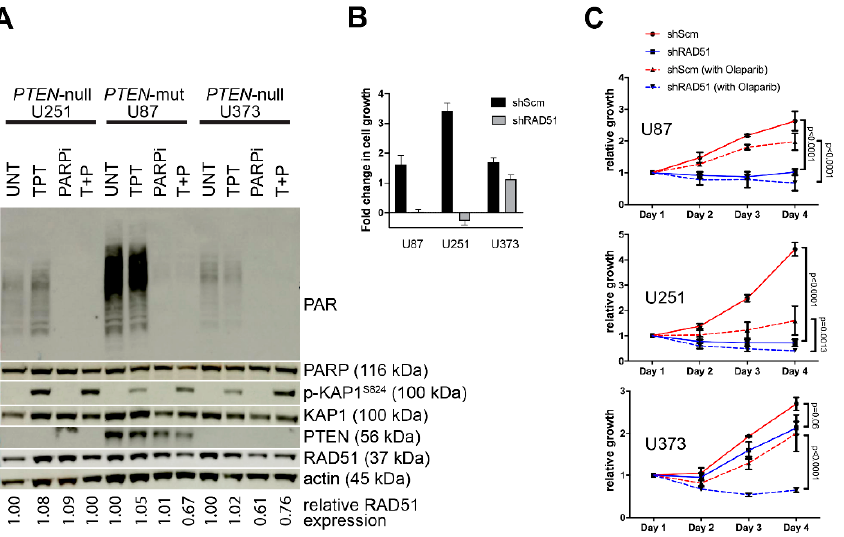
Figure 4. Cell proliferation analysis in PTEN-deficient GBM cell lines following treatment with PARP inhibitor (PARPi) olaparib. ( A ) GBM cells underwent treatment with olaparib (5 µ M pre-treatment for 30 min followed by 1 h at 37 ◦ C) and / or topotecan (5 µ M for 1 h at 37 ◦ C). Western analysis of the topotecan-treated cells displayed the DNA damage-induced ATM-dependent KAP-1 phosphorylation (Figure S2) and enhanced PARylation, while the olaparib treatment alone failed to induce KAP-1 and suppressed the basal PARylation and dual treatment results in KAP-1 phosphorylation in the absence of PARylation. ( B ) Cells that undergo shRAD51 -mediated knockdown of RAD51 display significant reduction in cellular growth. ( C ) While olaparib treatment (1 µ M) of shSCM -GBM control lines moderately impacts the GBM cell growth (compare the red solid line to the hashed line), olaparib treatment of shRAD51 -GBM lines shows cell loss (compare the blue solid line to the hashed line). The statistical analysis was performed using the 2-way ANOVA using the Tukey’s post hoc test with no correction.